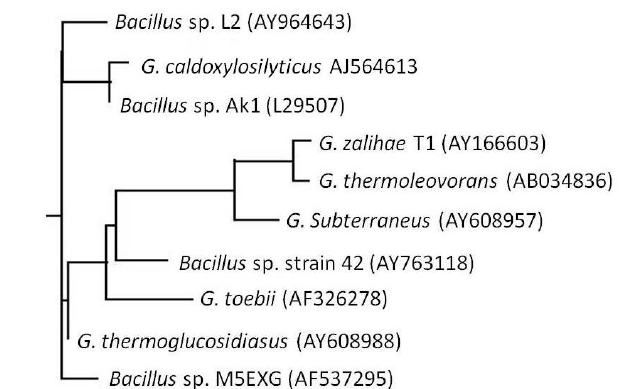
Figure 1. Rooted phylogenetic tree showing the relationship of isolate Bacillus sp. L2 to other Bacillus and Geobacillus species with their accession